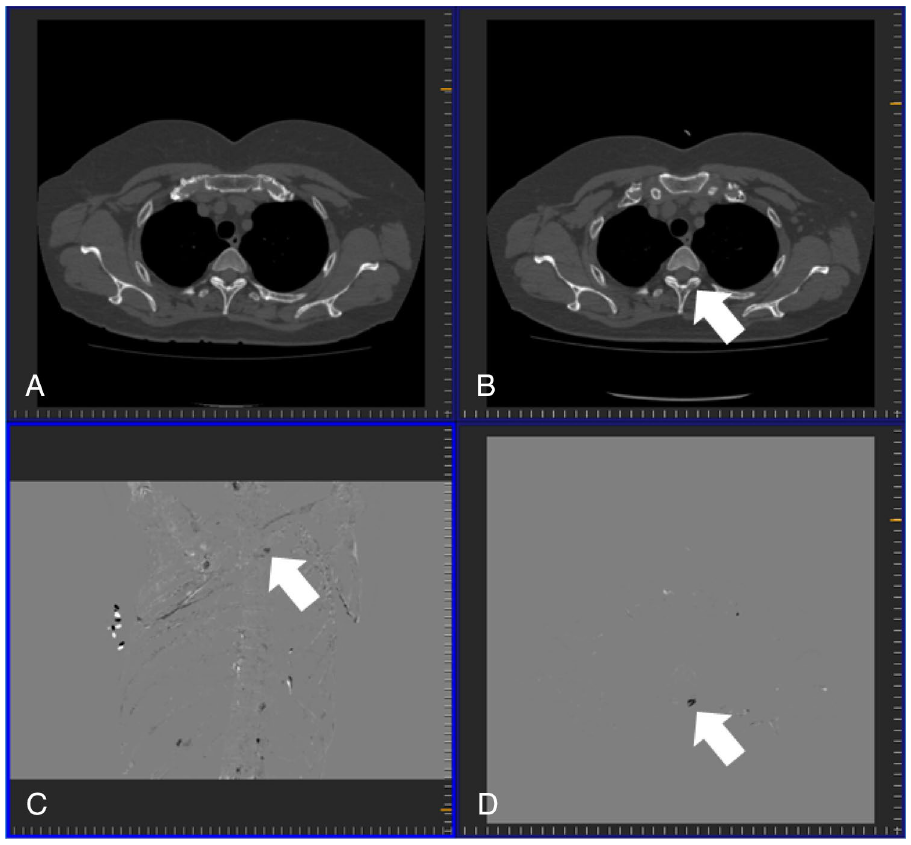
Figure 4. Osteolytic metastasis in the Th3 vertebra (arrow) of a 54-year-old female patient with breast cancer. ( A ) Previous computed tomography (CT) image; ( B ) current CT image; ( C ) temporal subtraction (TS) image; ( D ) projection image of TS